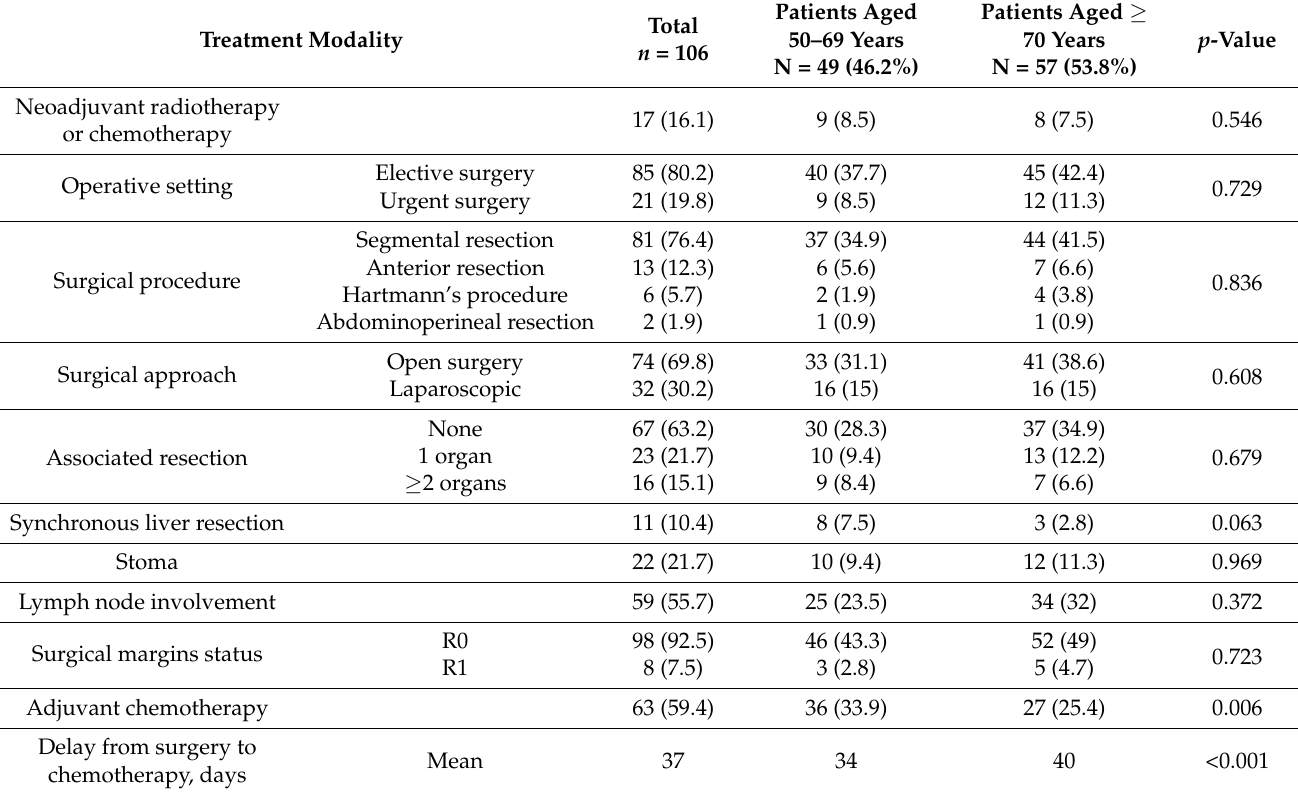
Table 2. Treatment approach.